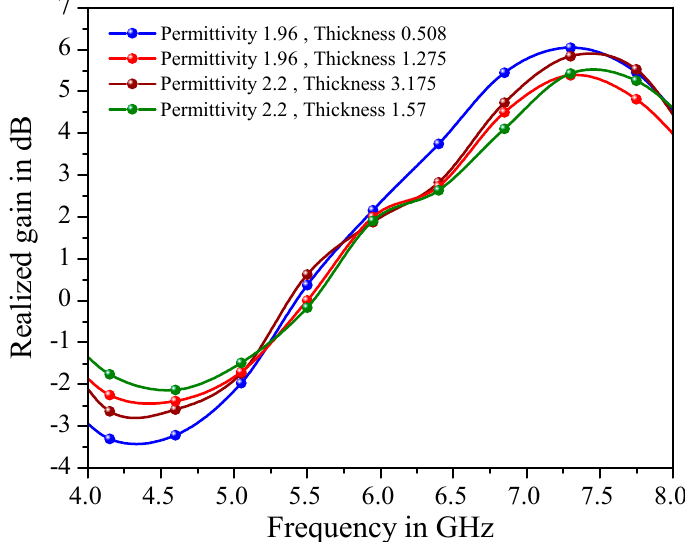
Figure 12. Realized gain of the proposed antennas versus the frequency in the range of interest.